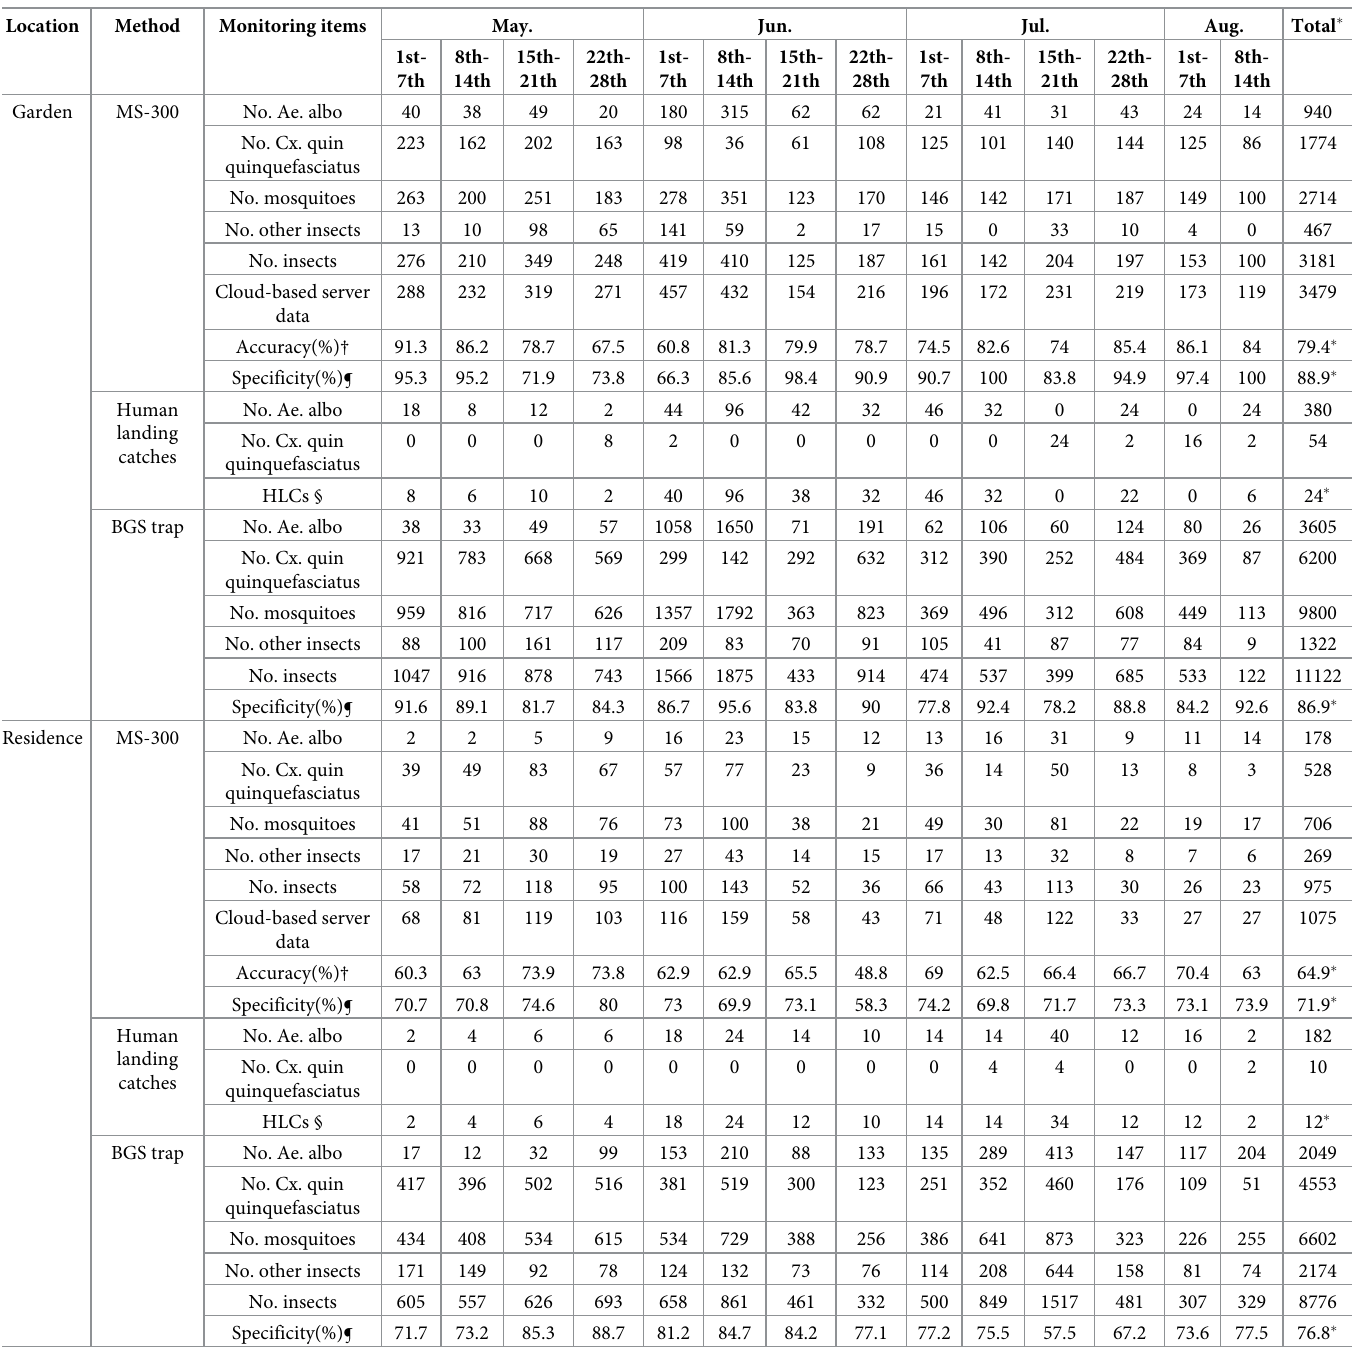
Table 1. Test of three monitoring methods on Ae . albopictus and Cx . quinquefasciatus in the field.